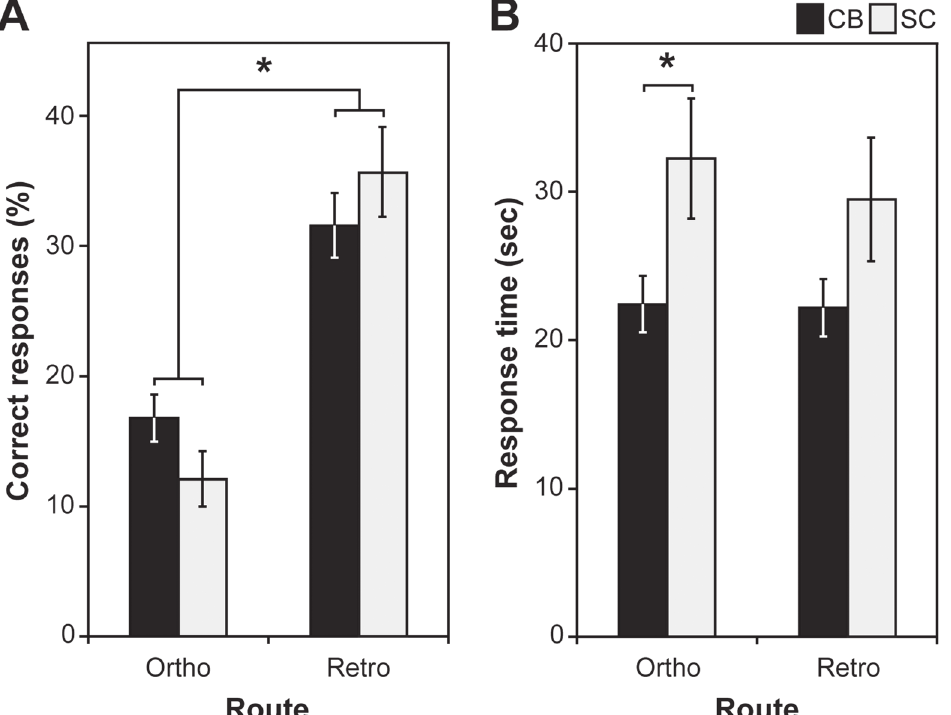
Fig 1. Orthonasal and retronasal odour free identification. Data are presented as mean ± standard error of the mean (SEM). A. Significant group x route interaction indicating better and worse performances respectively for orthonasal and retronasal odour free identification in congenitally blind (CB) compared to sighted controls (SC). B. Shorter response time in CB compared to sighted controls SC during the free identification task. * Significant at p <